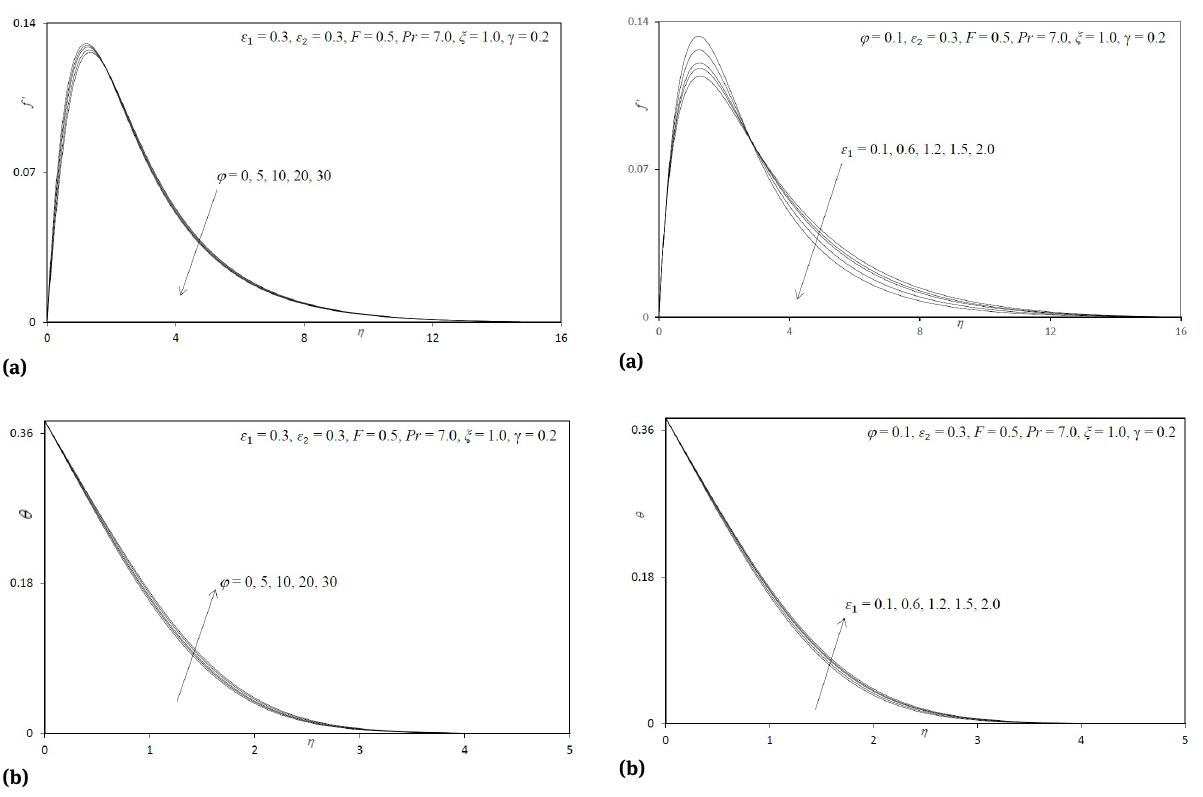
Fig. 3: (a) Effect of ϕ on Velocity Profiles; (b) Effect of ϕ on Tempera- ture Profiles;